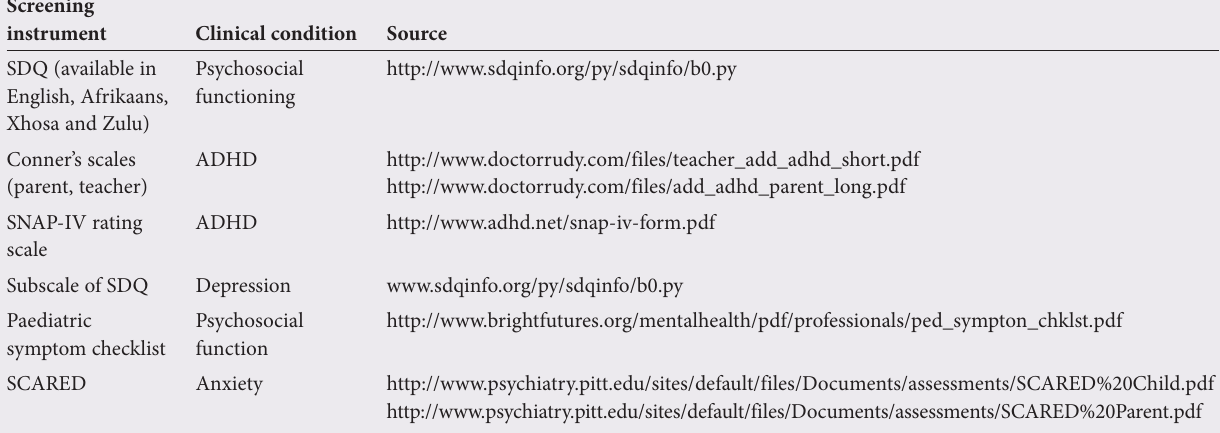
Table 1. Validated screening tools for mental disorders in children and adolescents*